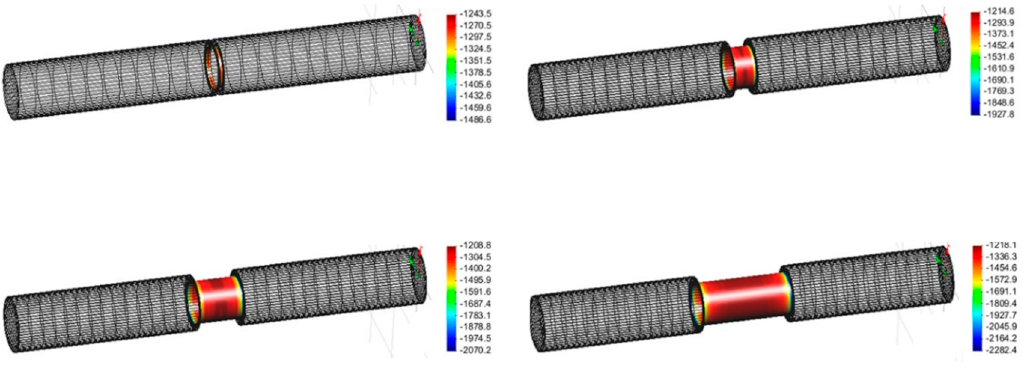
Figure 5. Simulation results (averaged protection potential, mV SCE ) according to the defect ratio: ( a ) 1%, ( b ) 5%, ( c ) 10%, ( d ) 20%.